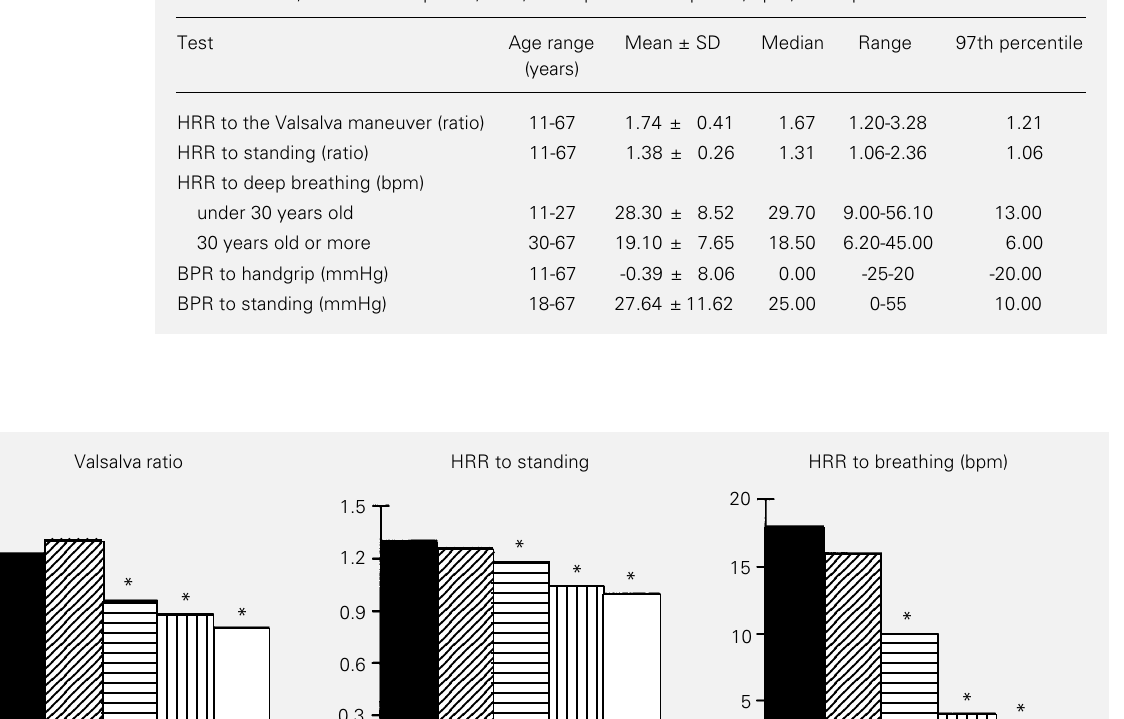
Table 2 - Results of cardiovascular autonomic tests in normal subjects.